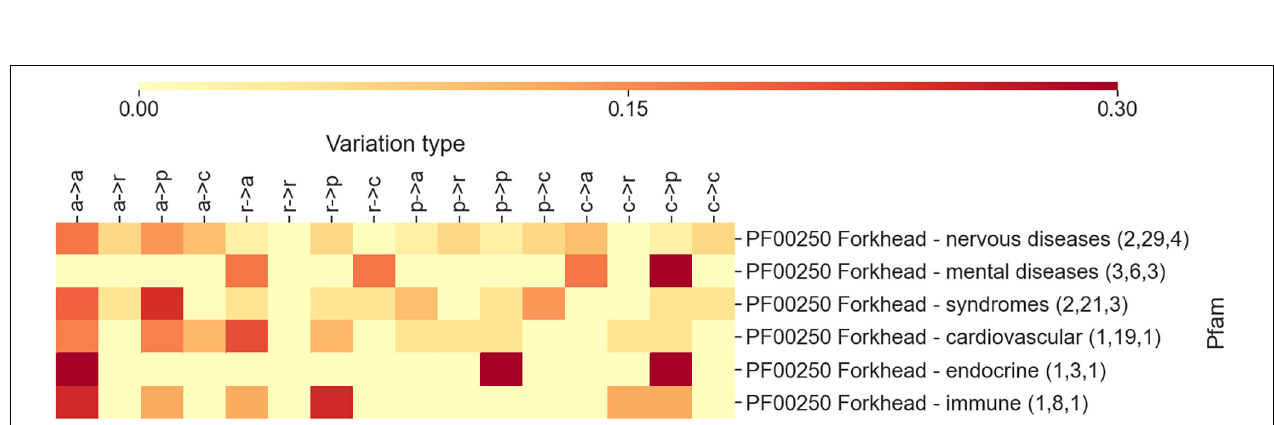
FIGURE 3 | The heatmap reporting, for each Pfam, the frequency of diseases (grouped into 17 different classes extracted from Disease Ontology) as retrieved from OMIMs, after the association via the disease type with Pfam. The numbers within parentheses are the number of proteins, the number of disease variations, and the number of Online Mendelian Inheritance in Man (OMIM) diseases associated with the Pfam, respectively. Each Pfam is labeled according to its functional class: DNAb, DNA-binding domain; Enz, enzymatic domain; TM, transmembrane; GF, growth factor; ACTINb, actin-binding domain; Sign, signaling; and Various, various functions associated. Mean and median Kullback–Leibler divergences (Eq. 2) between individual Pfam distributions and the background are 2.5 and 2.7 bits, respectively.